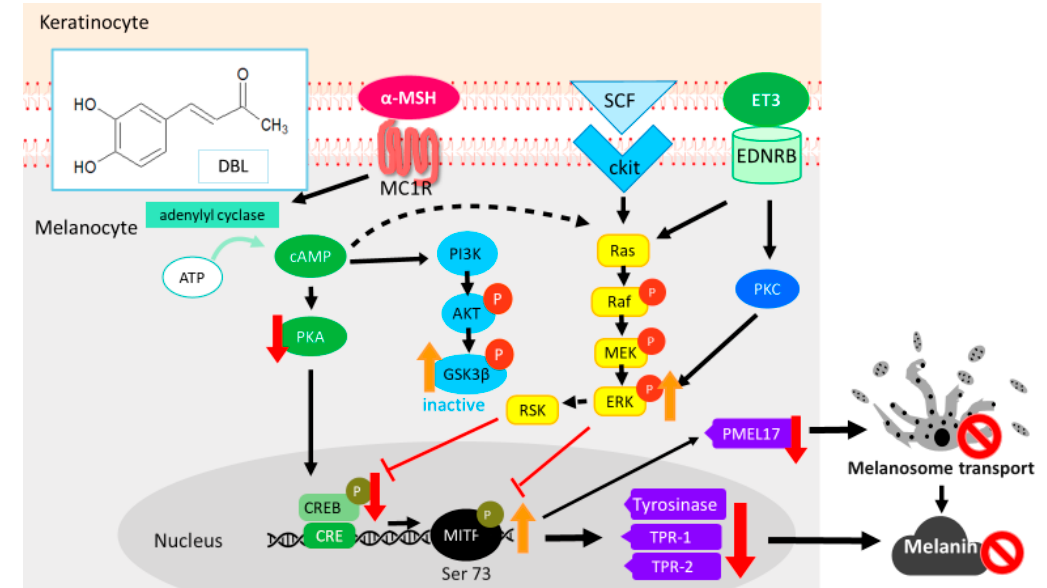
Figure 6. Schematic diagram showing the mechanism of DBL-mediated inhibition of melanogenesis in melanocytes.